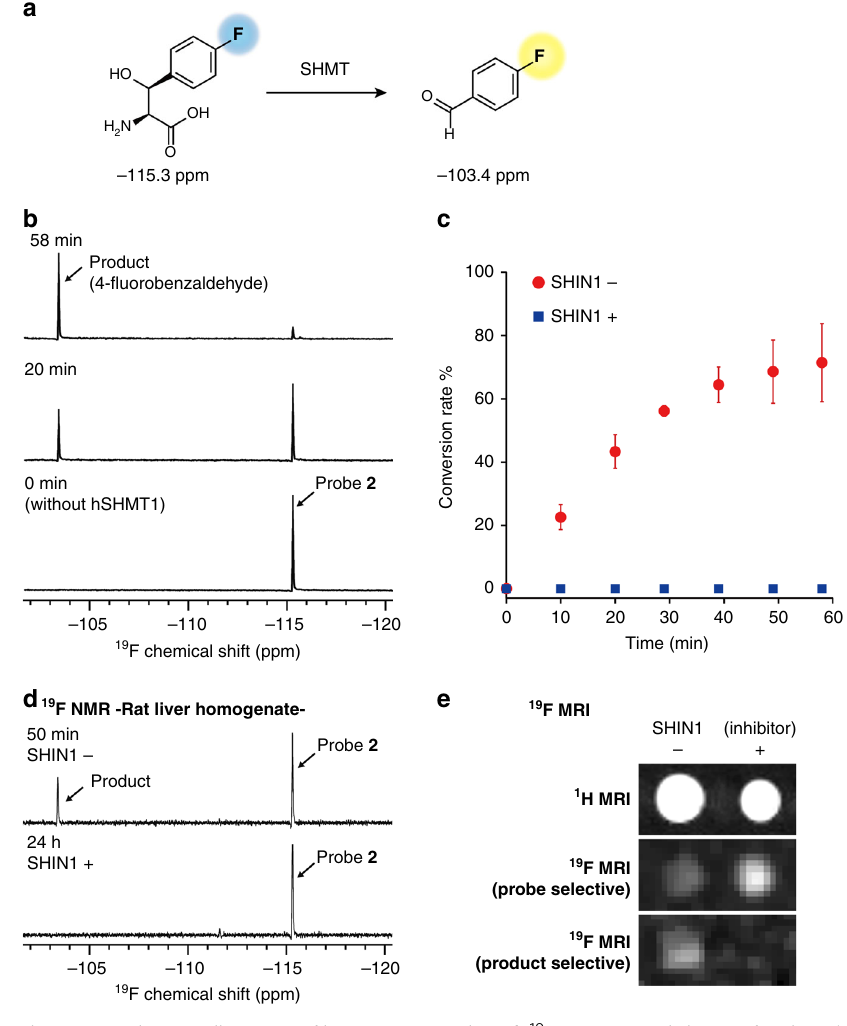
Fig. 5 NMR probe targeting hSHMT. a Schematic illustration of hSHMT NMR probe 2 . b 19 F NMR spectral change of probe 2 (5 mM) upon the addition of hSHMT1 (5 units/mL). Assay conditions: 5 units/mL hSHMT1, 50 mM HEPES buffer (pH 7.5), 100 mM NaCl, 0.5 mM EDTA, 1 mM DTT, 30% D 2 O, with or without inhibitor (±)-SHIN1 10 µ M, 0.1% DMSO, 37 °C. CF 3 COOH ( – 76.5 ppm) was used as the internal standard for 19 F NMR. c Conversion rate of hSHMT probe 2 by hSHMT1 with (blue square) or without (red circle) hSHMT inhibitor (±)-SHIN1 10 µ M. Error bars represent s.d., n = 3. d 19 F